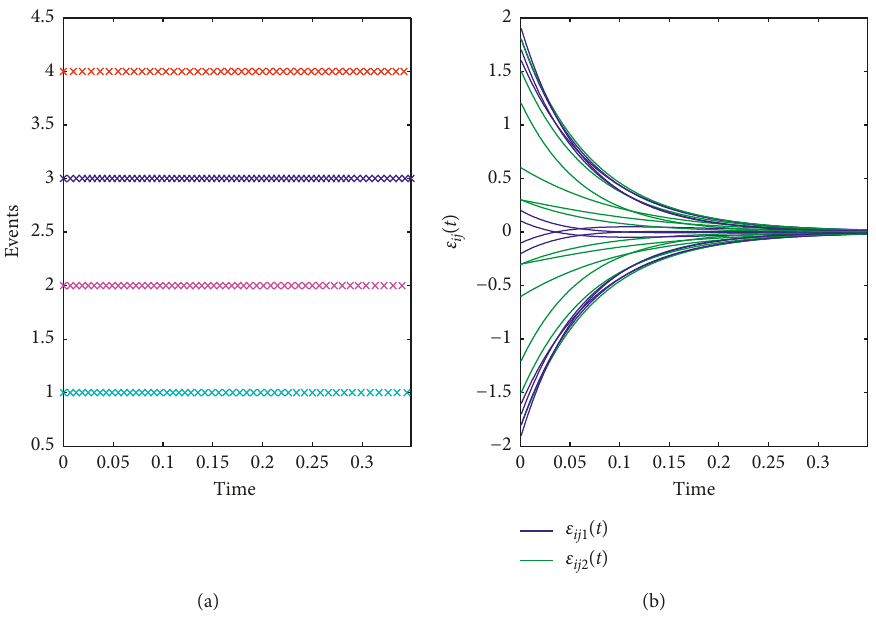
Figure 3: Time evolutions of the event-triggered controller and the synchronization errors in Example 2.